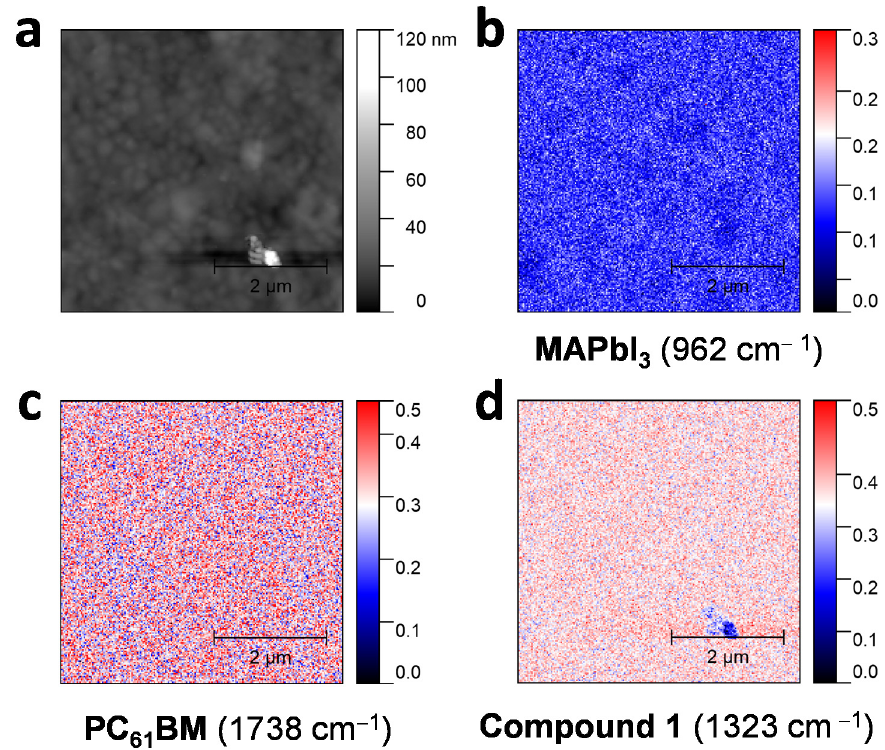
Figure 5. AFM topography of ITO/PTA/MAPbI 3 /PC 61 BM / 1 stack films ( a ) and the corresponding IR s-SNOM maps at the frequencies of 962 cm − 1 (MAPbI 3 , ( b )), 1738 cm − 1 (PC 61 BM, ( c )), and 1323 cm − 1 (compound 1 , ( d )).